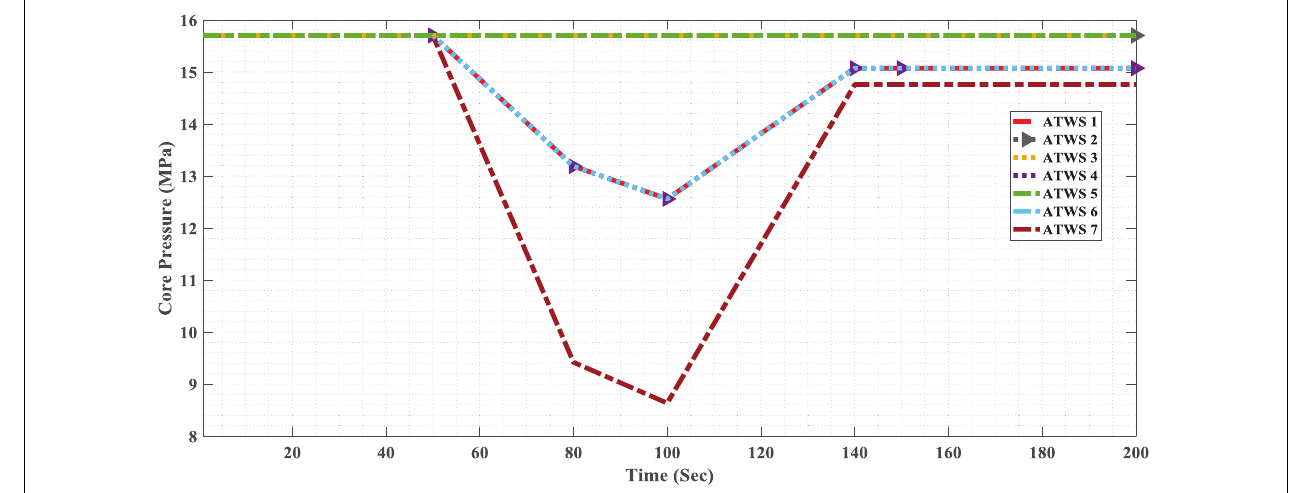
FIGURE 7 | Core pressure during ATWS scenarios.